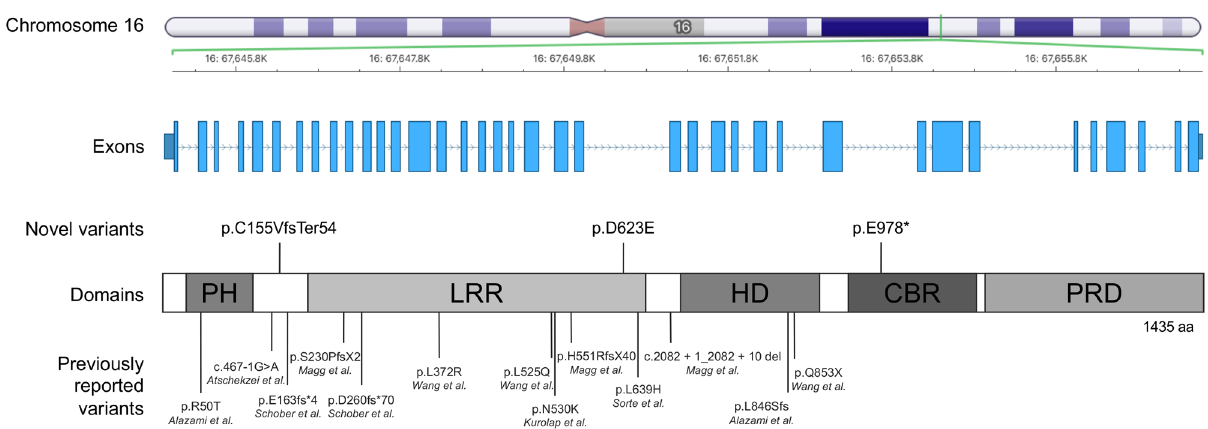
Figure 2. CARMIL2 gene and protein view with newly identified and previously published variants. Schematic representation of the intron–exon structure of the CARMIL2 gene, which is located on Chromosome 16. The three novel variants reported in this study are labelled above the schematic illustration of the protein domains of CARMIL2, along with the previously described variants below. PH Pleckstrin-Homology domain, LRR Leucine- Rich Region, HD Helical Dimerization domain, CBR Capping Protein-Binding Region, PRD Proline-Rich